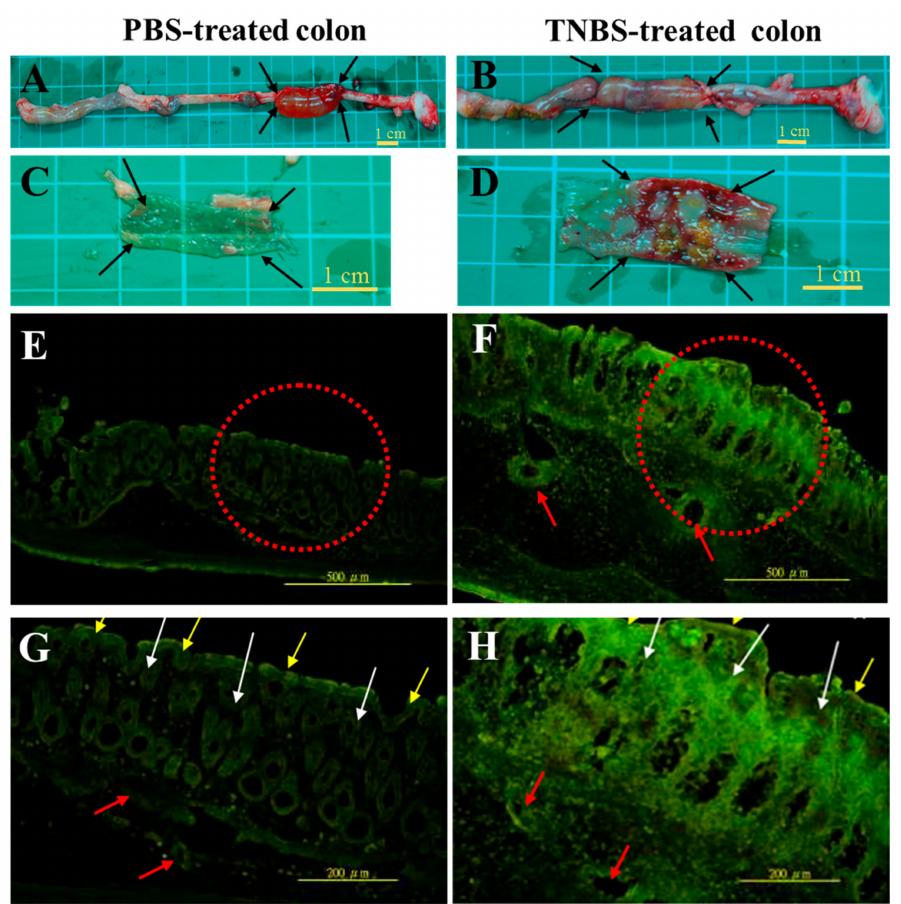
Figure 2. The adhesion of FL-Labeled HA conjugateson the normal and ulcerous mucosa of rat (cid:48) s-colons. The HA-FL conjugate is more adhesive on the ulcerous mucosa than on the normal colon. The mucosal tissue of normal rats is shown in panels A , C , E and G . The ulcerous tissue of rats with colitis is shown in panels B , D , F and H . Black arrows indicate the macroscopic appearance of a normal colon ( A ) and an ulcerous colon ( B ). The inner appearances of a normal colon ( A ) and an ulcerous colon ( B ) are presented in panels C and D , respectively. The fluorescence expression of a colon tissue cryosection [Figure E and F is at 10 × magnification (red dashed cycle); Figure G and H is at 200 × magnification]. Yellow arrows, white arrows, and red arrows indicate the mucosal layer, chorionic villi, and vascular vessels,